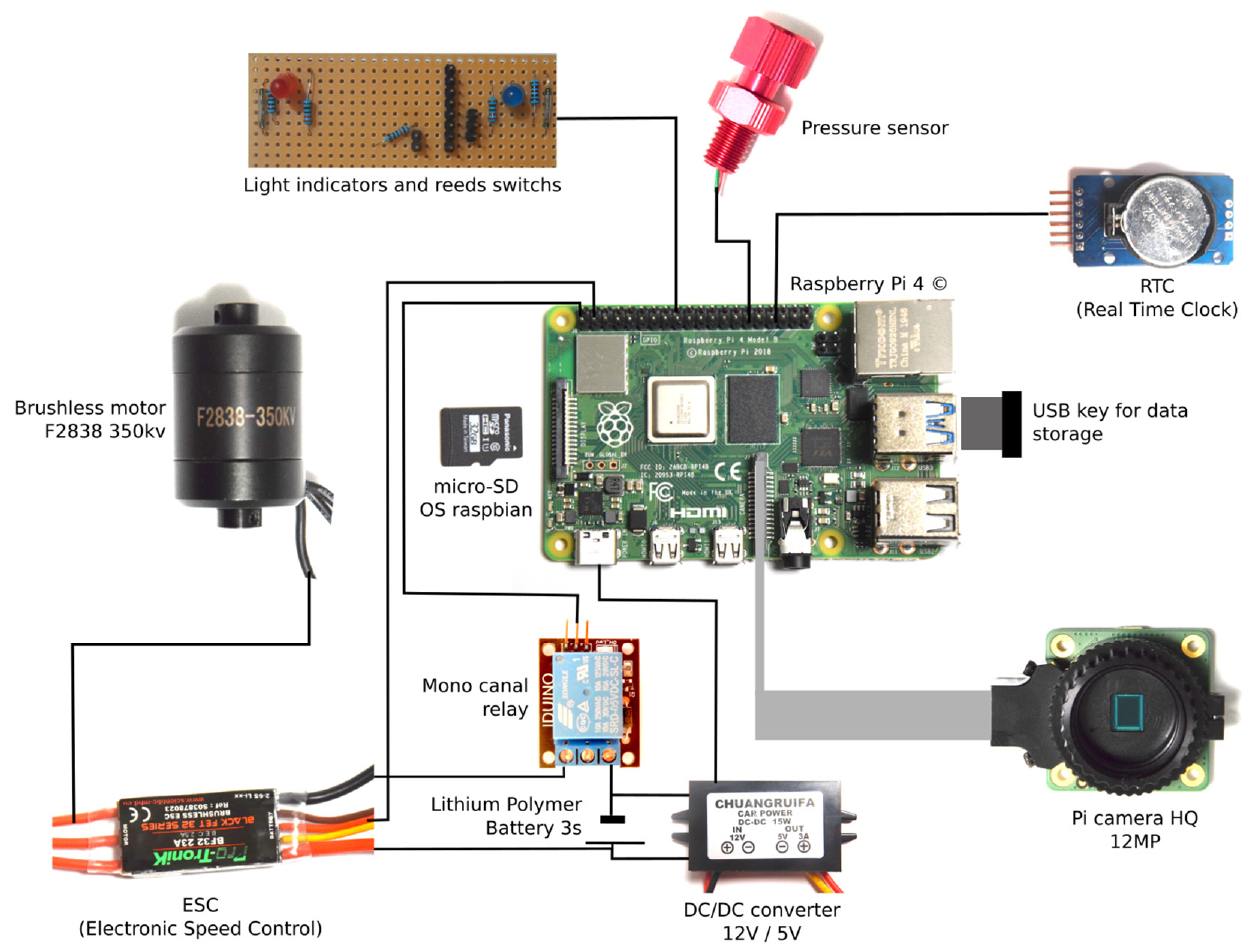
Figure 7. Sketch of the KOSMOS electronics.